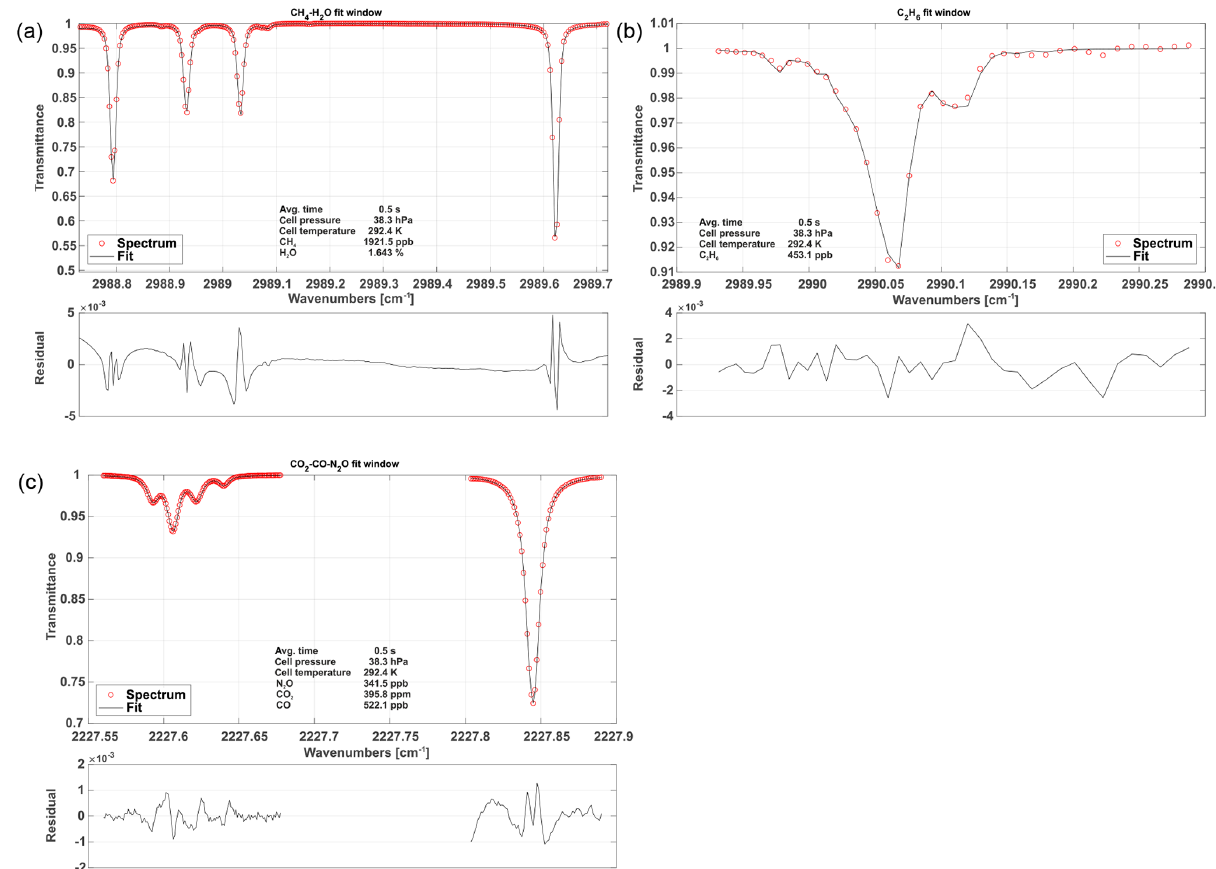
Figure 5. Typical, normalized spectra for each fit window including fits and associated residuals. The first fit window (a) includes CH 4 and H 2 O absorption features. Panel (b) depicts C 2 H 6 absorption. The (c) spectrum shows CO, CO 2 and N 2 O absorption.